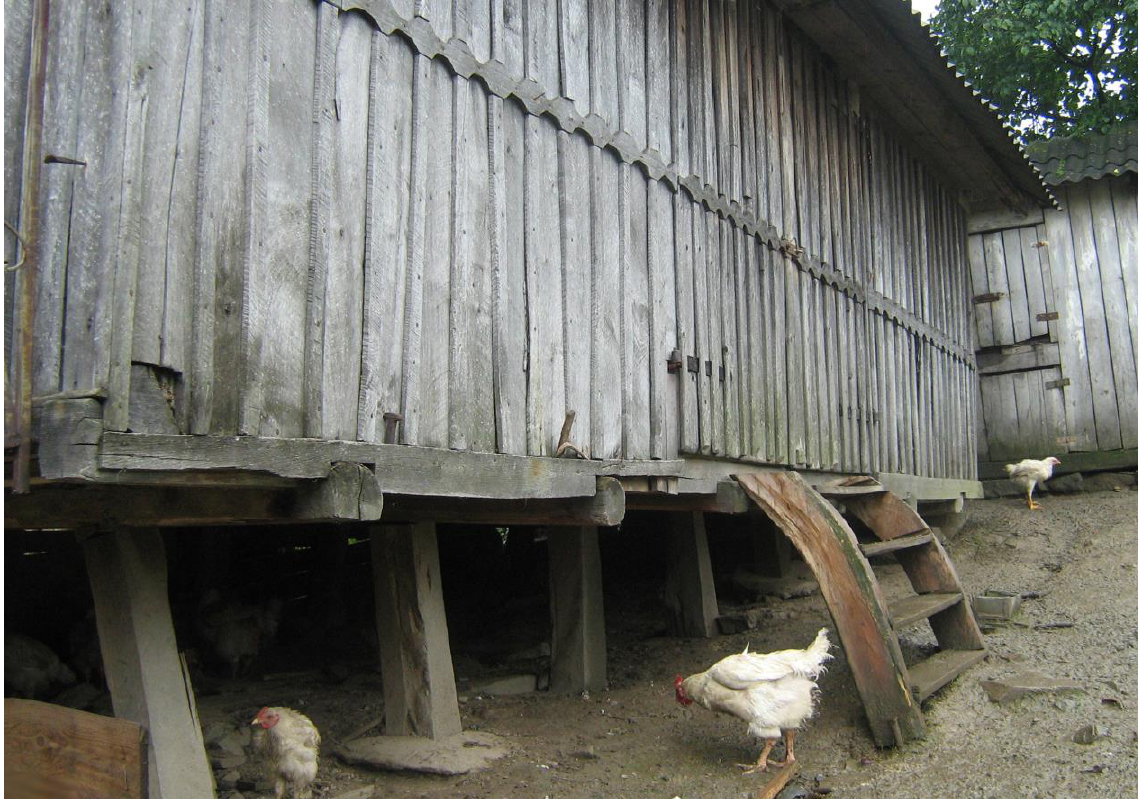
Figure 10. An example of a modern platform structure on sloped ground in the village of